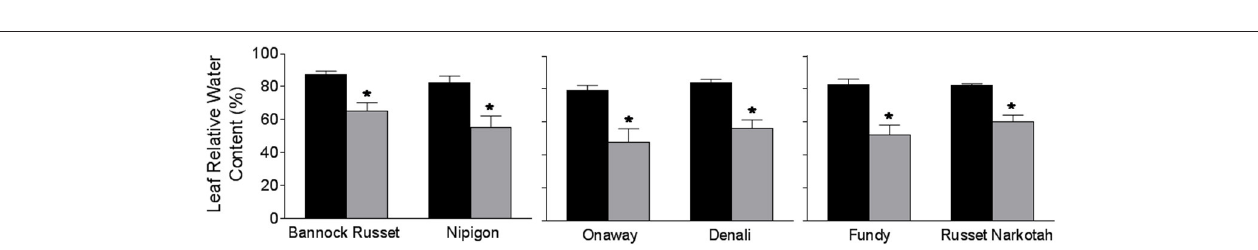
Frontiers in Plant Science |